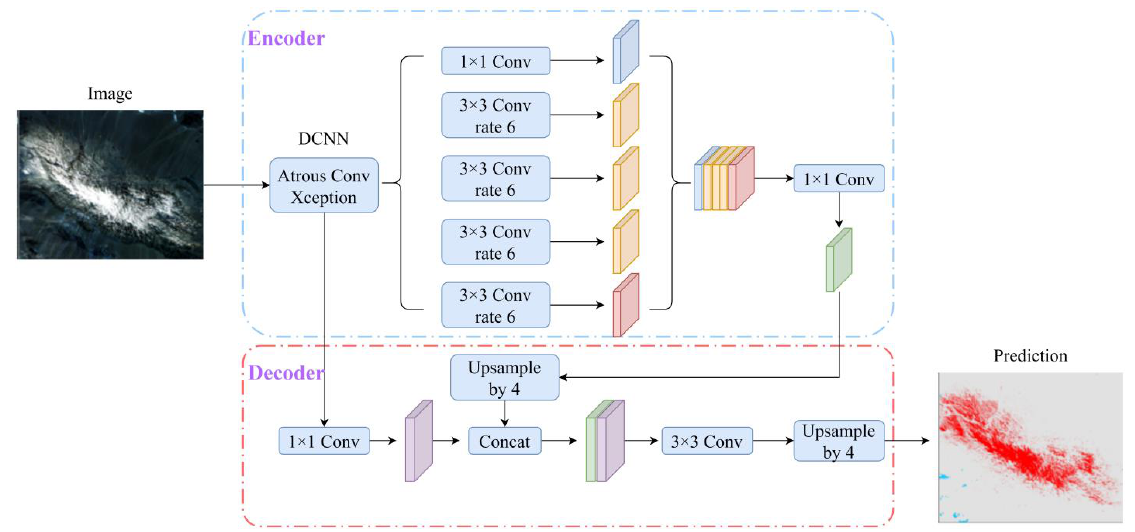
Figure 2. DeepLab v3+ structure [21]. It adopts encoder-decoder structure. The arrows in the figure represent the data flow. The red, blue and gray in the prediction map represent different ground objects.